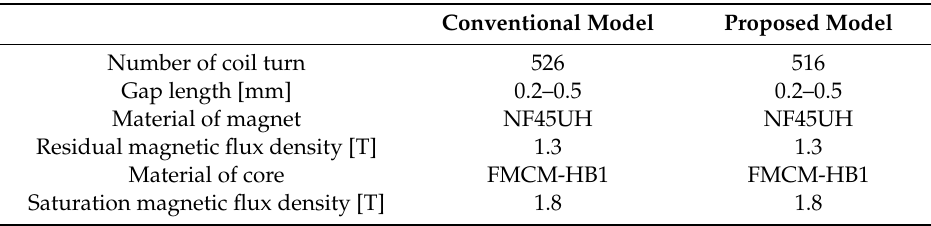
Figure 6. Flux flow of the conventional model and proposed model. Table 1.